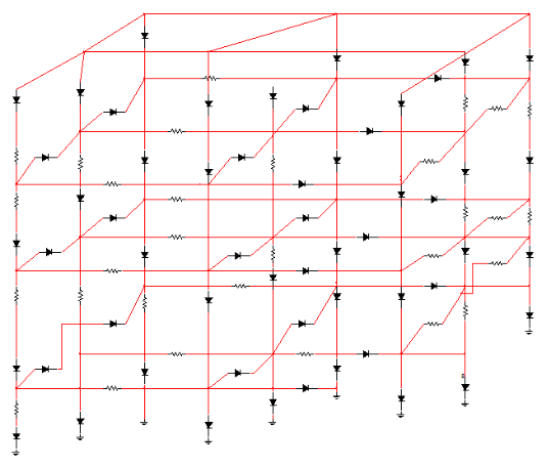
Figure 5. Equivalent circuit of the nanocomposite .